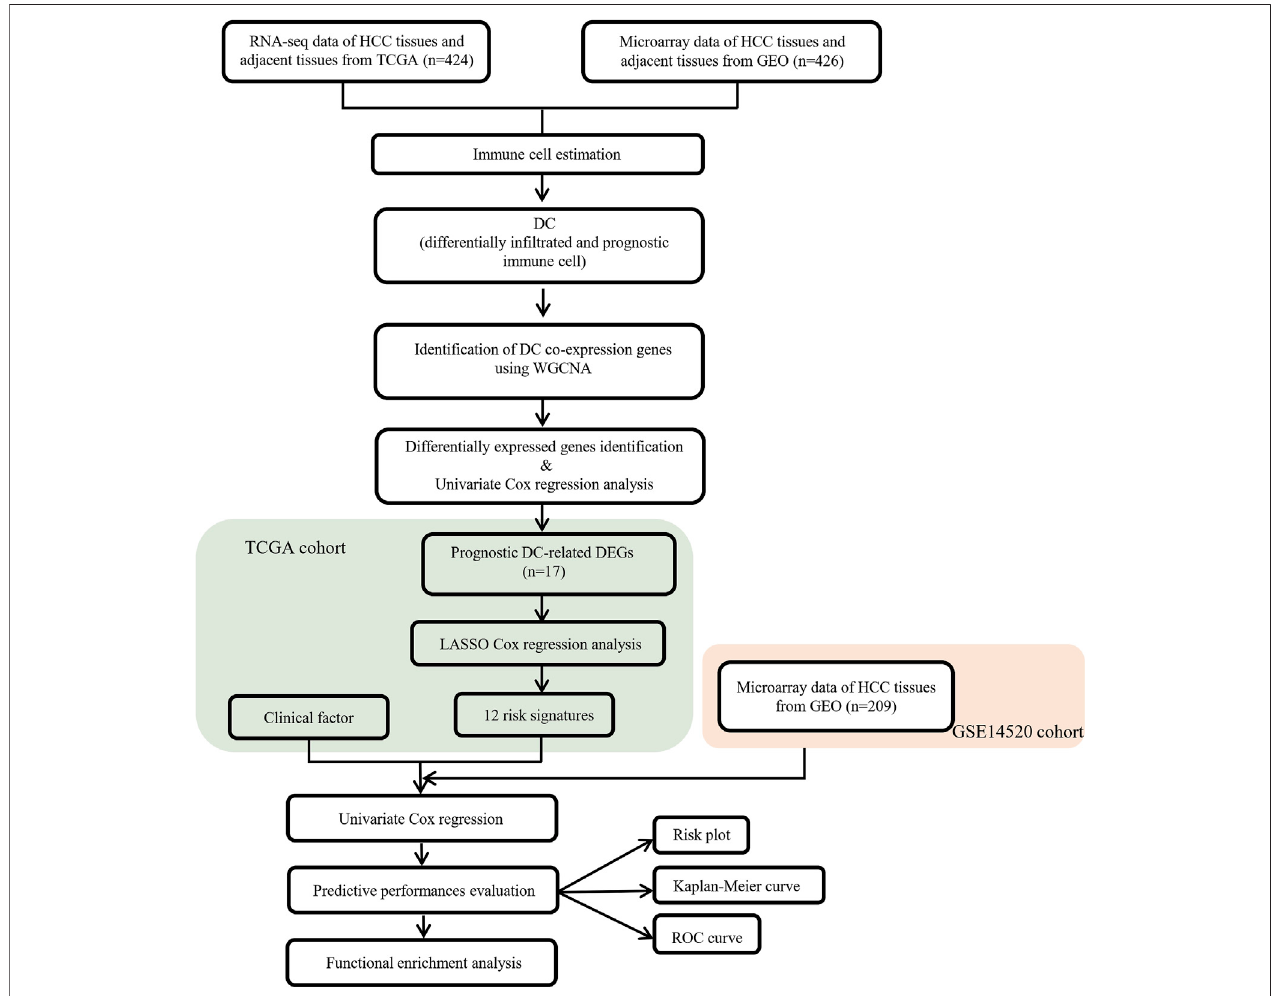
FIGURE 1 | Flow chart of data collection and